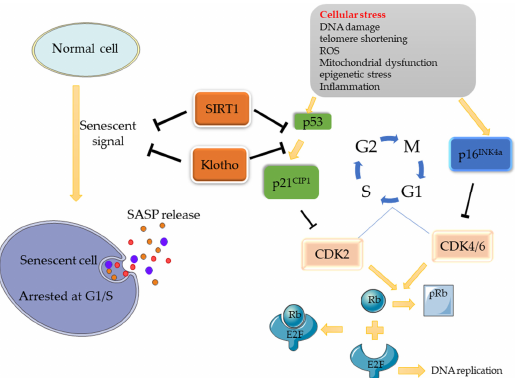
Figure 1. Potential Signaling Pathway of Cell Senescence. When normal cells are stimulated by cell stress, the p53/p21 and p16 pathways will be activated, thus inhibiting the activity of CDK, and, consequently, inhibiting the phosphorylation of Rb. Rb binds to E2F, which promotes DNA repli- cation, and inactivates it, eventually causing cell replication arrested at the G1/S phase, where cel- lular senescence occurs. As senescence regulatory factors, SIRT1 can deacetylate p53 and interfere with its nuclear translocation process, while Klotho can also inhibit senescence signals by inhibit- ing the p53/p21 pathway, thereby regulating cell senescence.